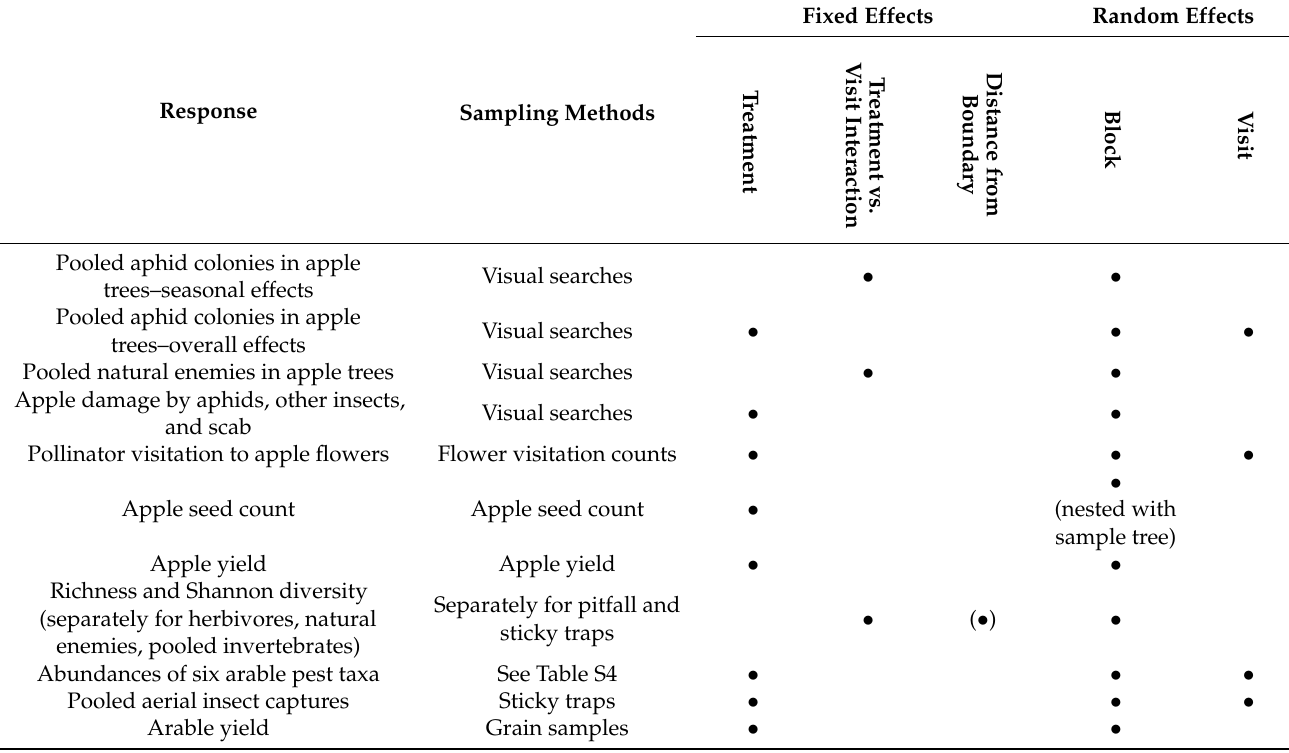
Table 2. Model building specifications, showing which fixed and random effects were applied to each response variable. ‘Treatment’ fixed effect refers to understorey management (flowering or mown). The main effect of treatment was removed from the ‘treatment vs. visit interaction’ model, to test treatment separately for each visit. Bracket symbols represent where the variable was applied to some models within that